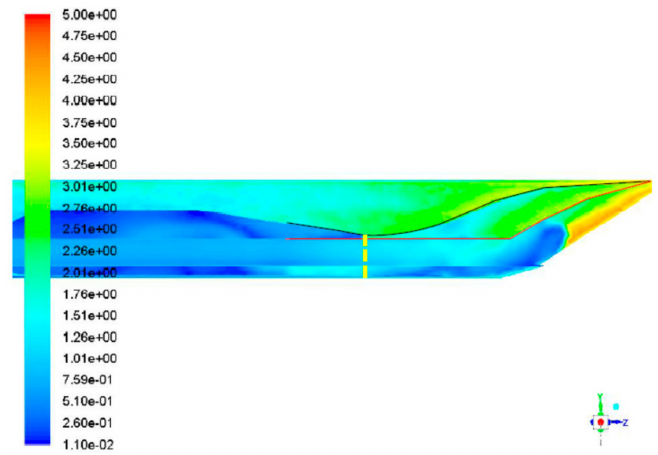
Figure 24. Three-dimensional analysis of the ramjet and scramjet (Mach